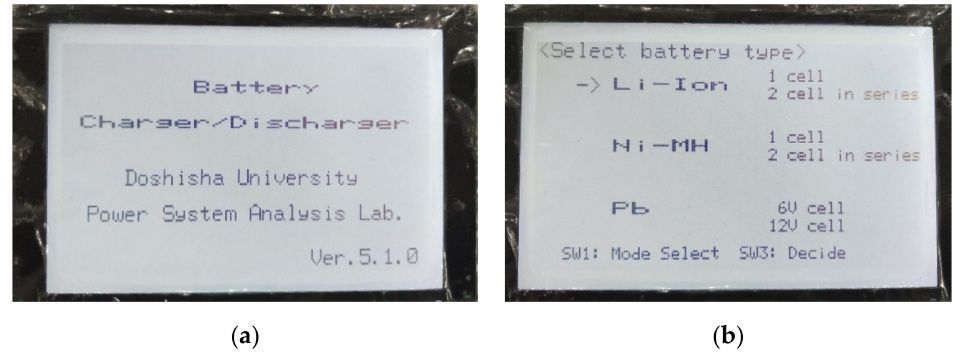
Figure A1. Interface of the improved MTC: ( a ) first page, ( b ) battery type selection menu and configuration.